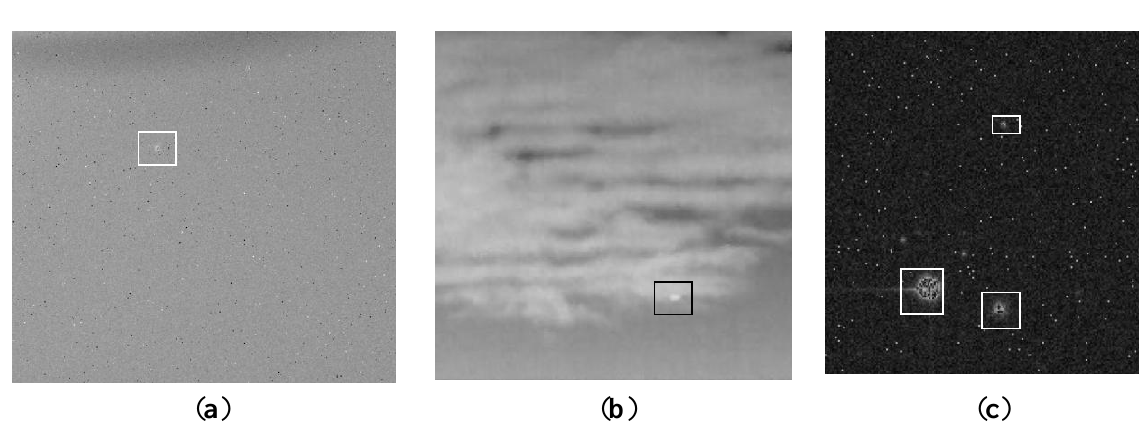
Figure 6. Original infrared image. ( a ) Deep space image. ( b ) Cloud image. ( c ) Multi-target image.